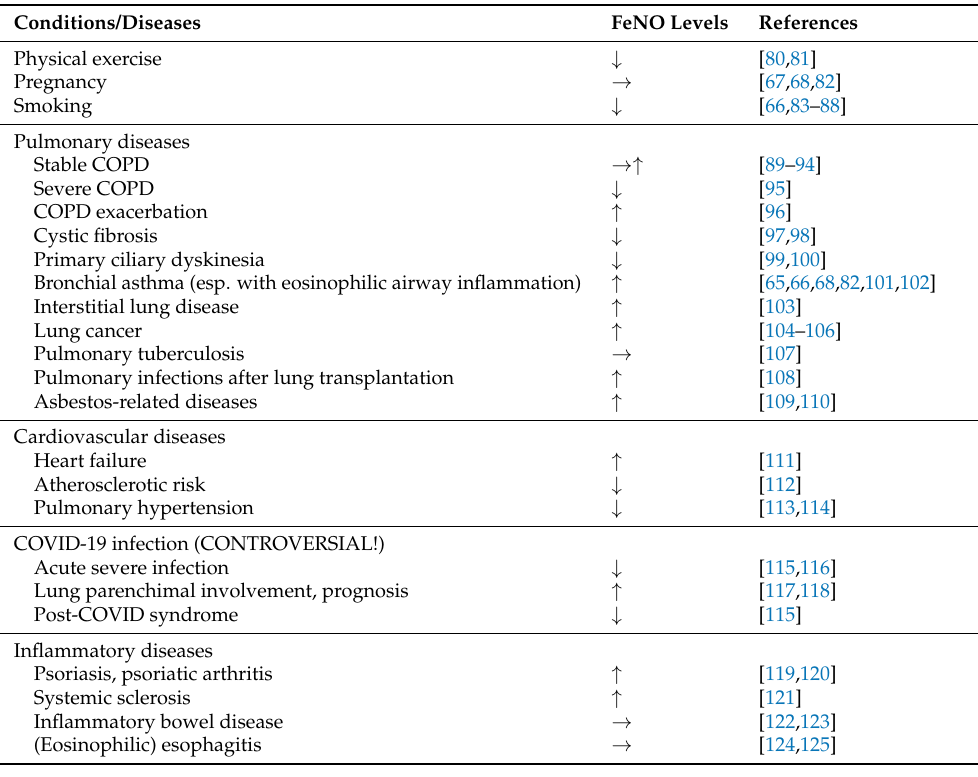
Table 1. FeNO alterations in different conditions and